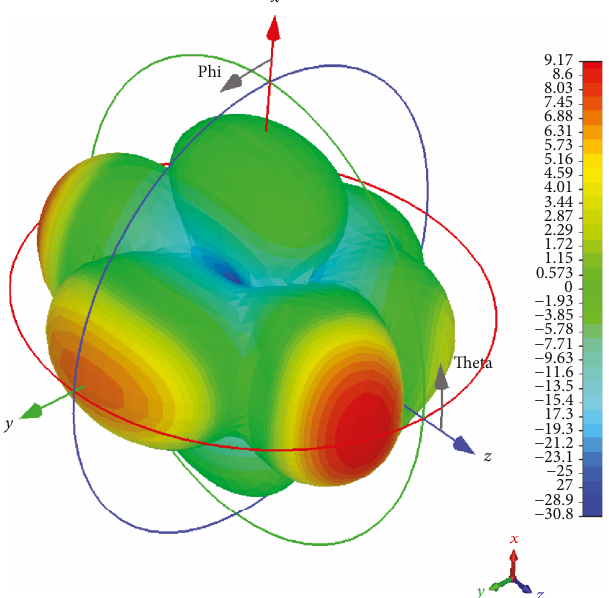
Figure 8: Far- fi eld pattern of a four-antenna array